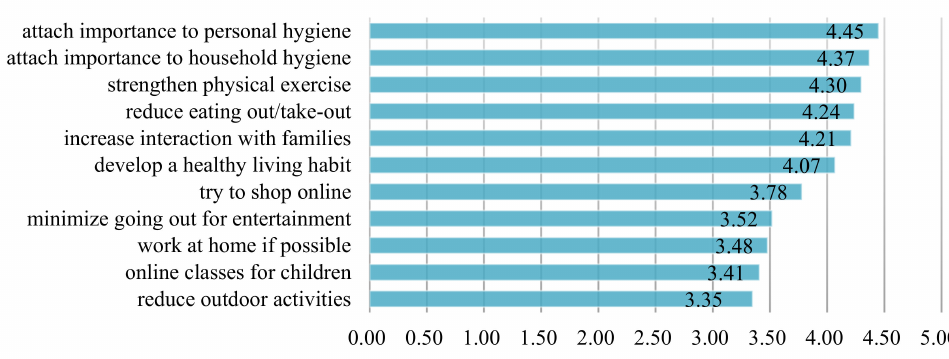
Figure 3. Changes in the people’s living habits in the COVID-19